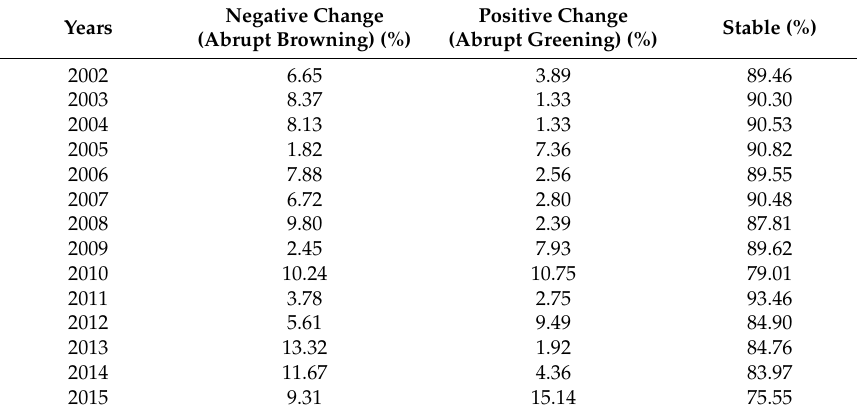
Table 4. Statistical results of area percentages of negative, positive, and stable trend changes for each year of the study period.